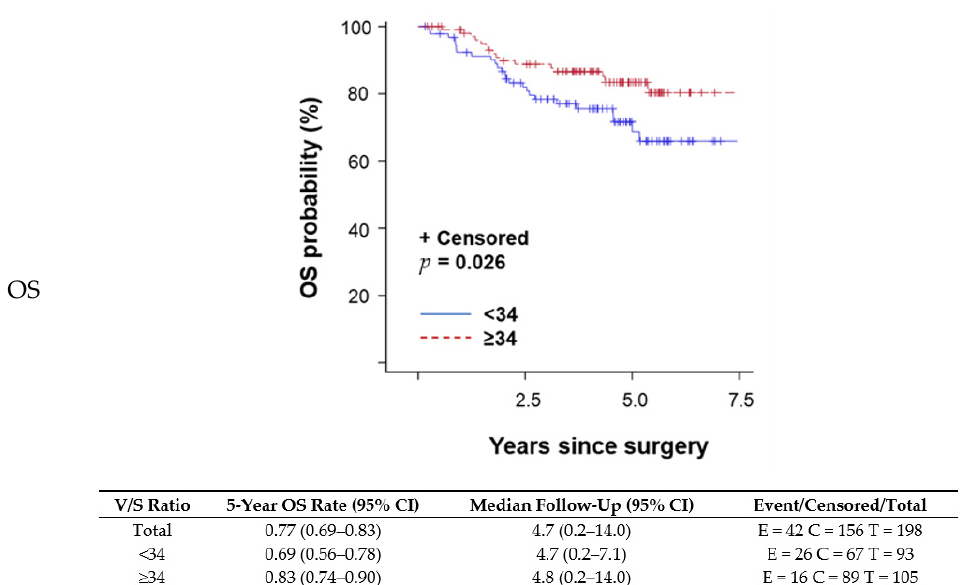
Figure 1. Kaplan–Meier survival plots and detailed survival rates stratified by the ratio of total visceral adipose tissue to total subcutaneous adipose tissue (V/S ratio) for ( A ) distant recurrence-free survival (DFS), ( B ) any recurrence-free survival (RFS), and ( C ) overall survival (OS). Abbreviations: CI, confidence